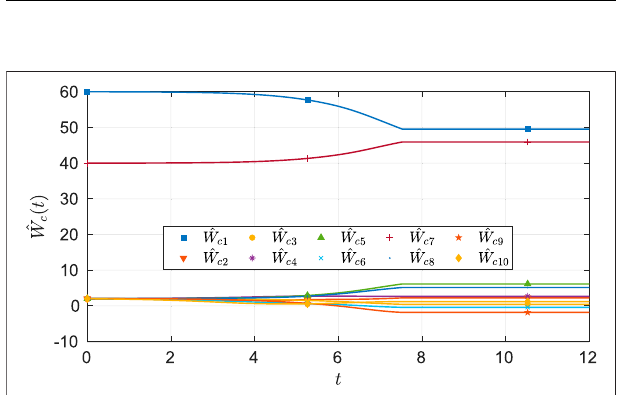
FIGURE 6 | State trajectories for the four-state dynamical system using MBRL with FCL in the original coordinates. The dash lines represent the user- selected safe set.